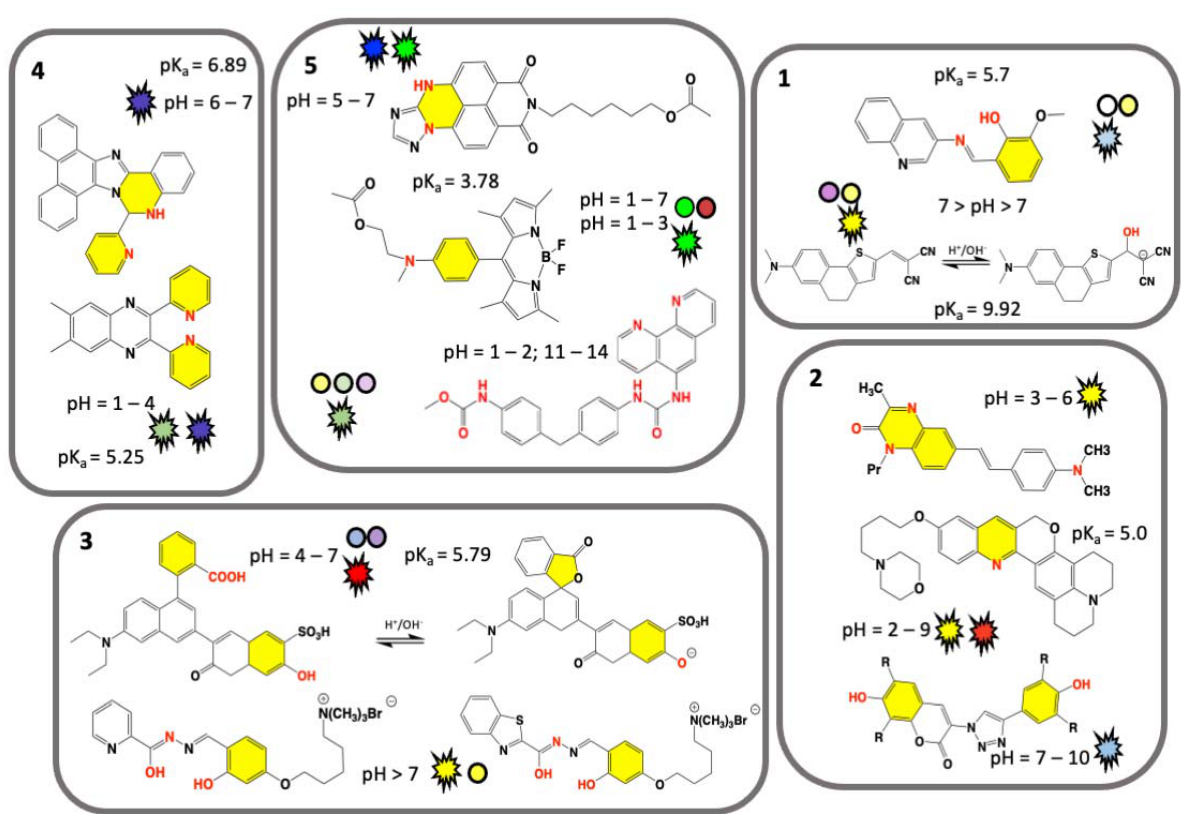
Figure 1. Chemical structures of recent synthetic molecular organic visual pH sensors grouped on the base of a common visual response or chemical features. Nitrogen and oxygen atom groups responsible for protonation/deprotonation are marked in red, and their chemical ring(s) marked in yellow. Sensor colorimetric response and pH value are represented by a colored sphere, while fluorescence emission by a flashing shape. Color matches to the sensor real color within the displayed pH range. Unique value of pKa is displayed. Box 1. Classical colorimetric and fluorescent pH VSs [22,40]. Box 2. Predominant fluorescent pH VSs [41–43]. Box 3. Designed water-soluble pH VSs [44–46]. Box 4. AIEgens pH VSs [47,48]. Box 5. Polymeric pH VSs [49–53]. Adapted from references indicated in square